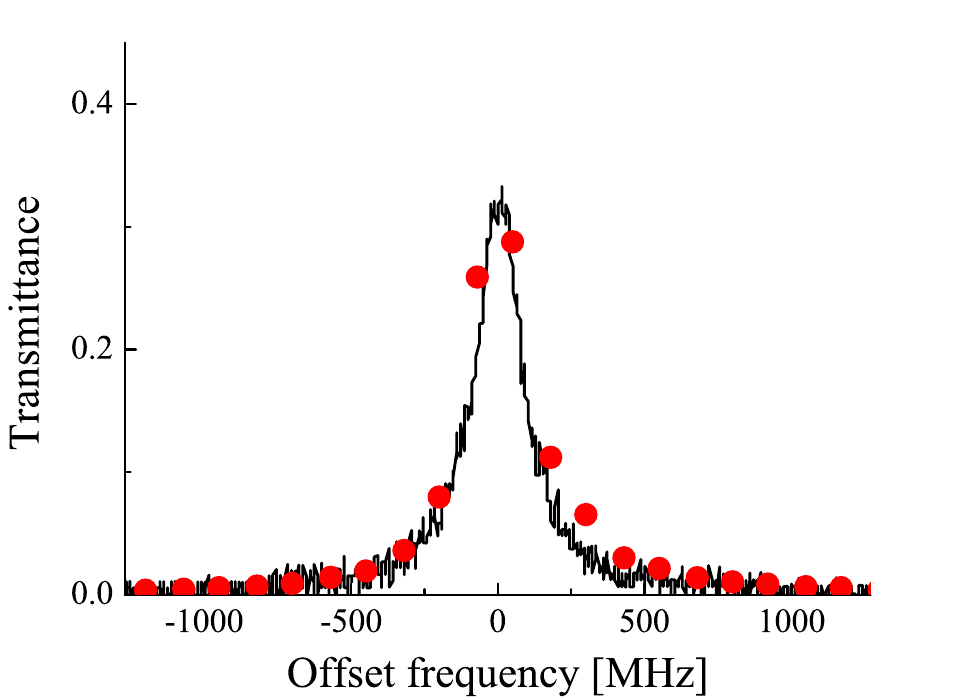
Figure 20. Transmittance of a narrow passband in a dual section FBG, where x-axis shows offset frequency from the center of the passband, Solid line and dots denotes results by the fast sweeper using an SSB modulator and conventional technique using a tunable laser, respectively.